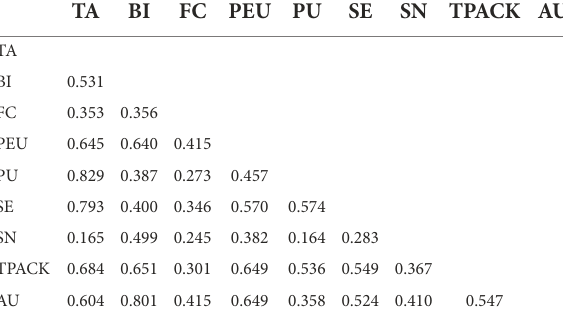
TABLE 5 HTMT (heterotrait–monotrait ratio of correlations) values. TA